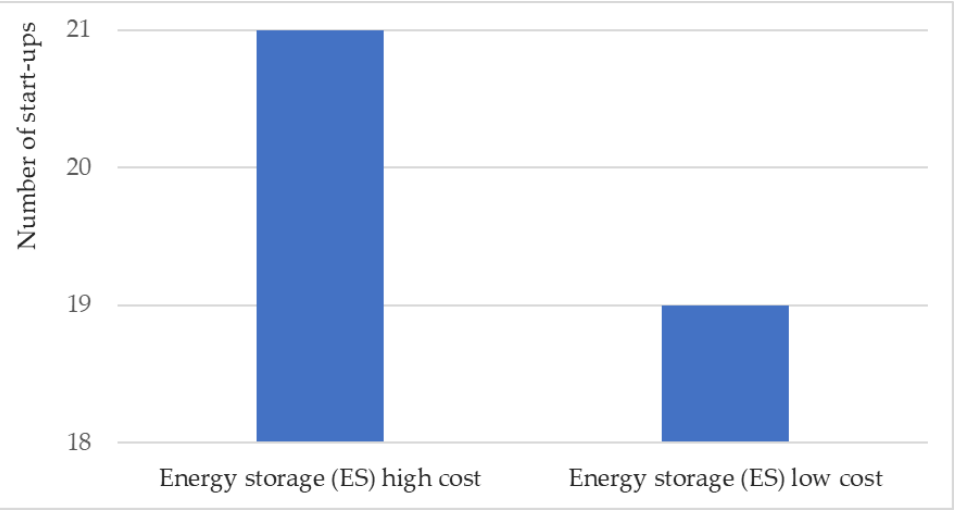
Figure 13. The biggest possible reductions of start-ups in the modeled system taking into account the different costs of ES operation.